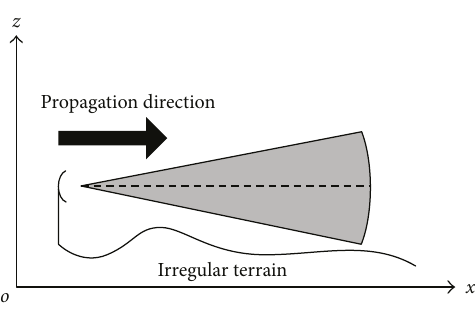
Figure 1: Paraxial propagation over irregular